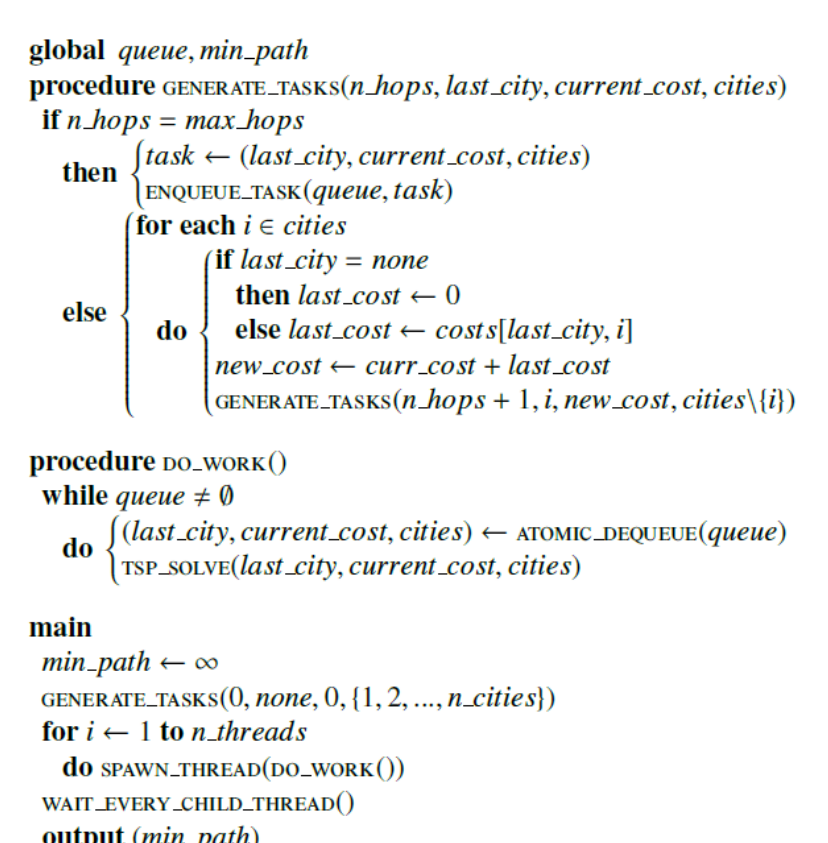
Figure A5. Pseudo-code for the multi-threading TSP version